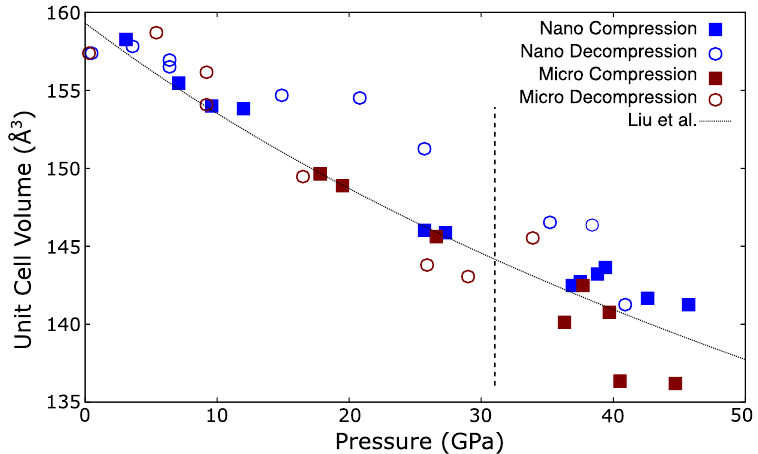
Figure 3. Unit cell volume vs. pressure for Fm ¯3 m cerium dioxide micro- and nanopowders on compression and decompression. Vertical dashed line indicates nominal transition pressure from the Fm ¯3 m phase to Pnam , note that the Fm ¯3 m phase persists above this. Uncertainties from LeBail fits are typically around 0.1 Å 3 , and smaller than plotting points.